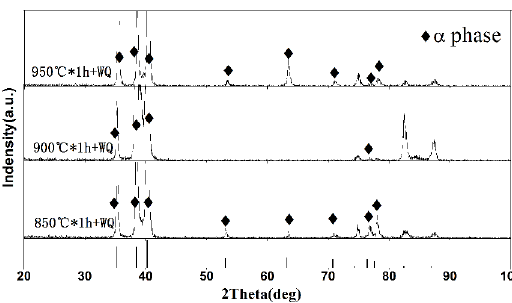
Figure 2. The XRD profiles with different heat treatment